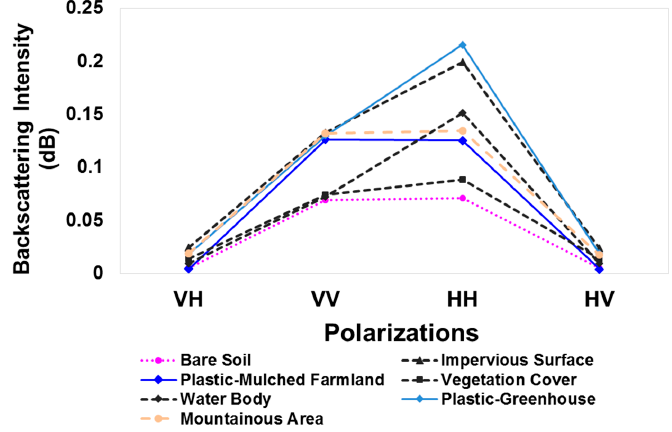
Figure 5. The backscattering intensity of land cover types on Radarsat-2 images in Guyuan.